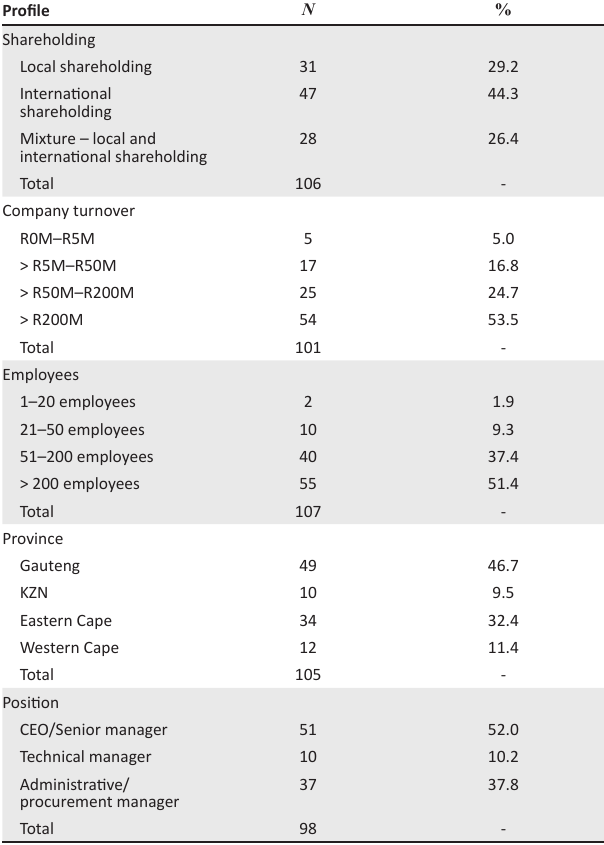
TABLE 2: Respondents profile.